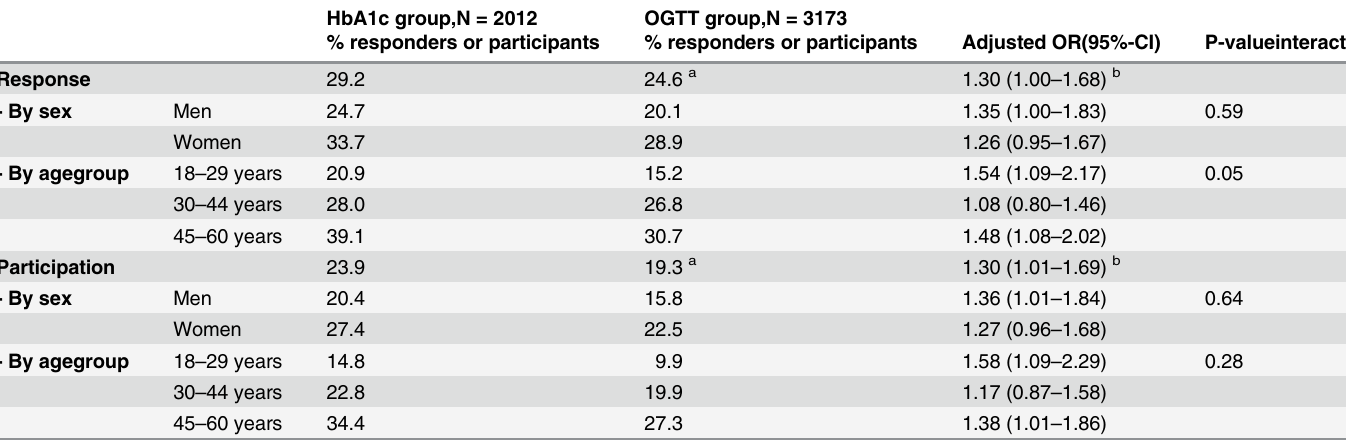
Table 1. Differences in response and participation between the HbA1c group and the OGTT group. OGTT group = people offered screening by means of an oral glucose tolerance test; HbA1c group = people offered screening by means of a glycated hemoglobin measurement; Adjusted OR = odds ratio for response or participation, adjusted for age and sex; CI = confidence interval.